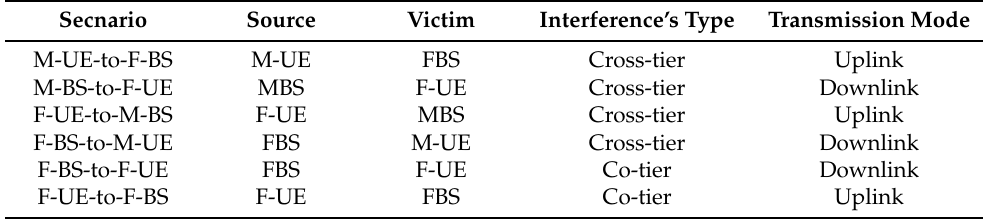
Table 1. Summary of the interference